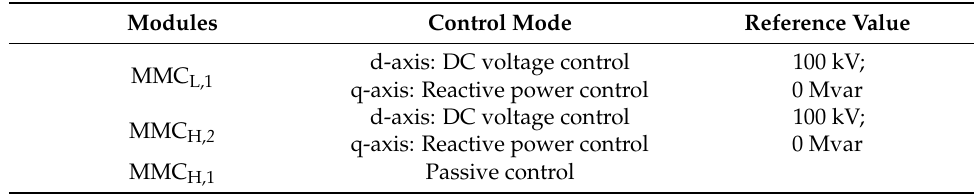
Table 5. Control mode and reference value of the